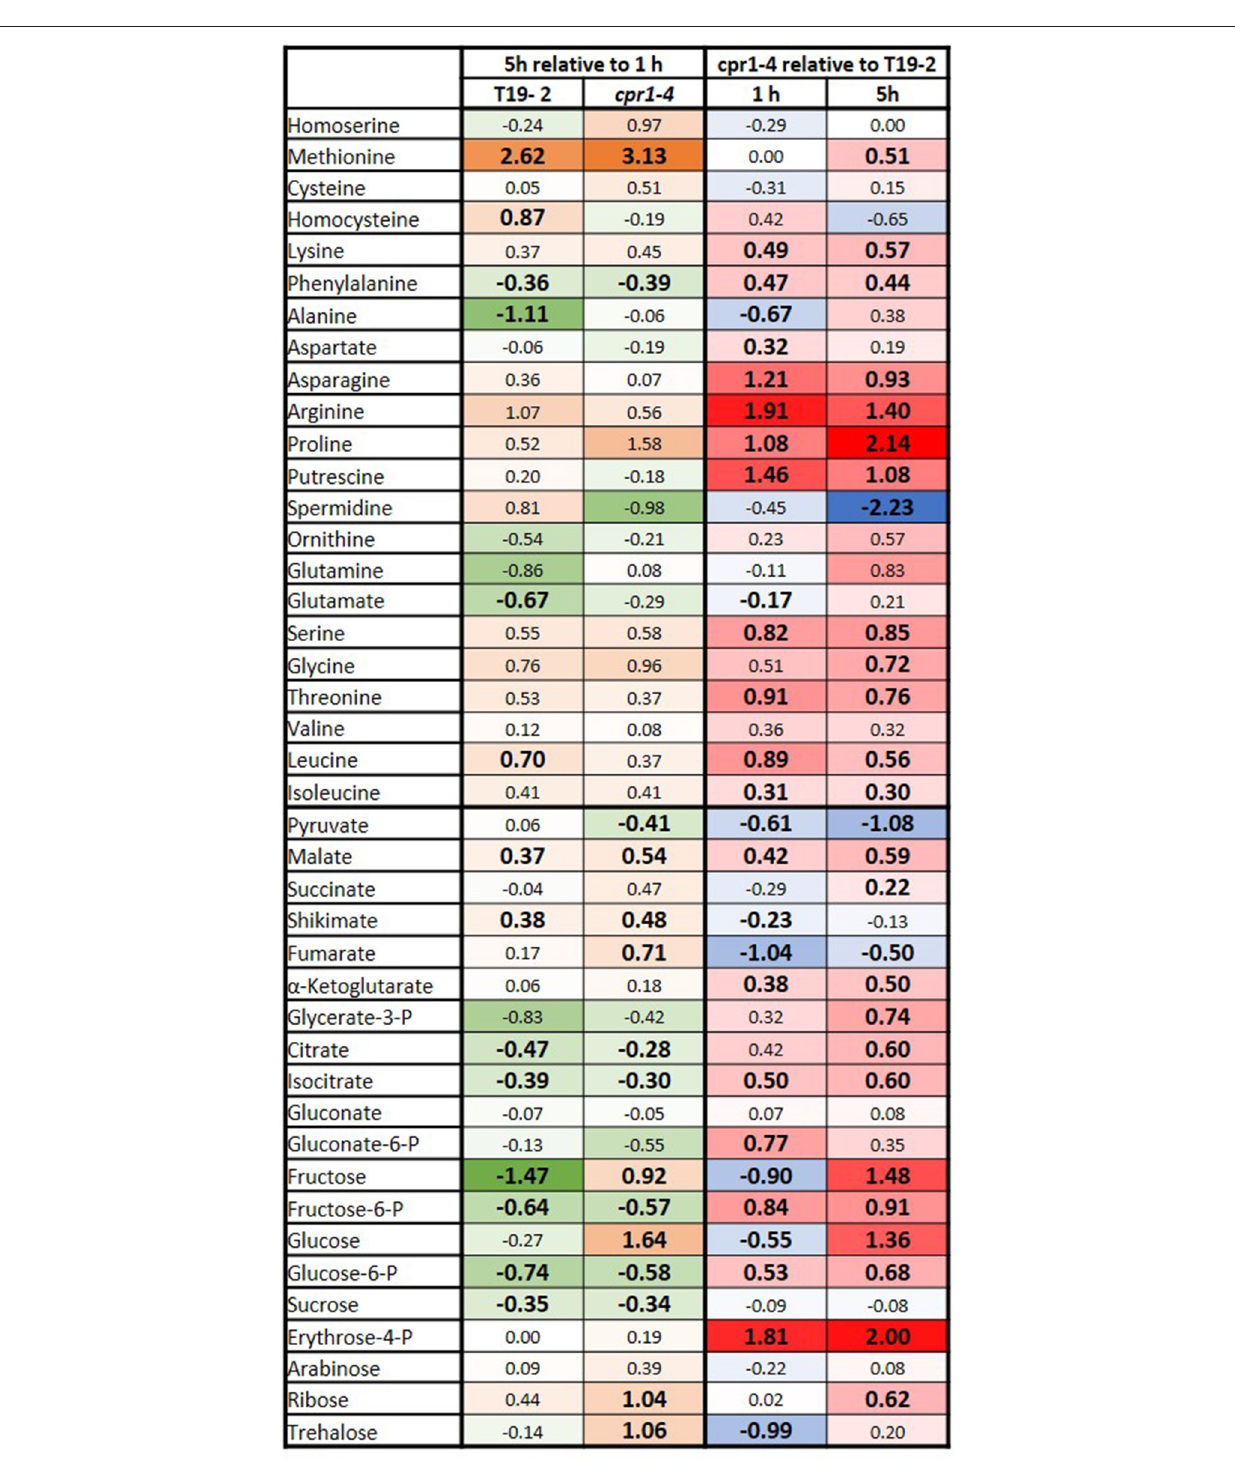
Frontiers in Plant Science |